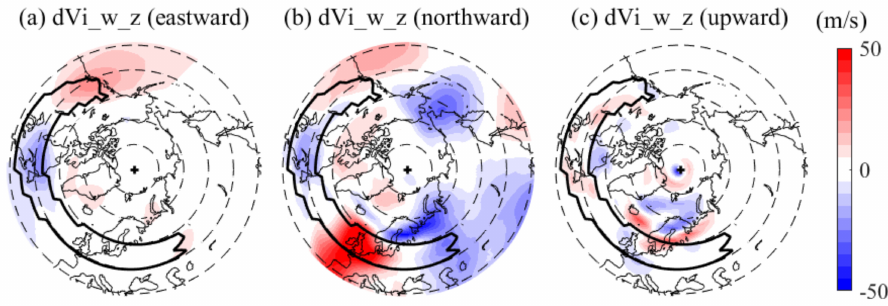
Figure 5. Vertical ion velocities caused by SAPS-induced ( a ) eastward wind, ( b ) northward wind, and ( c ) upward wind at 2200 UT.